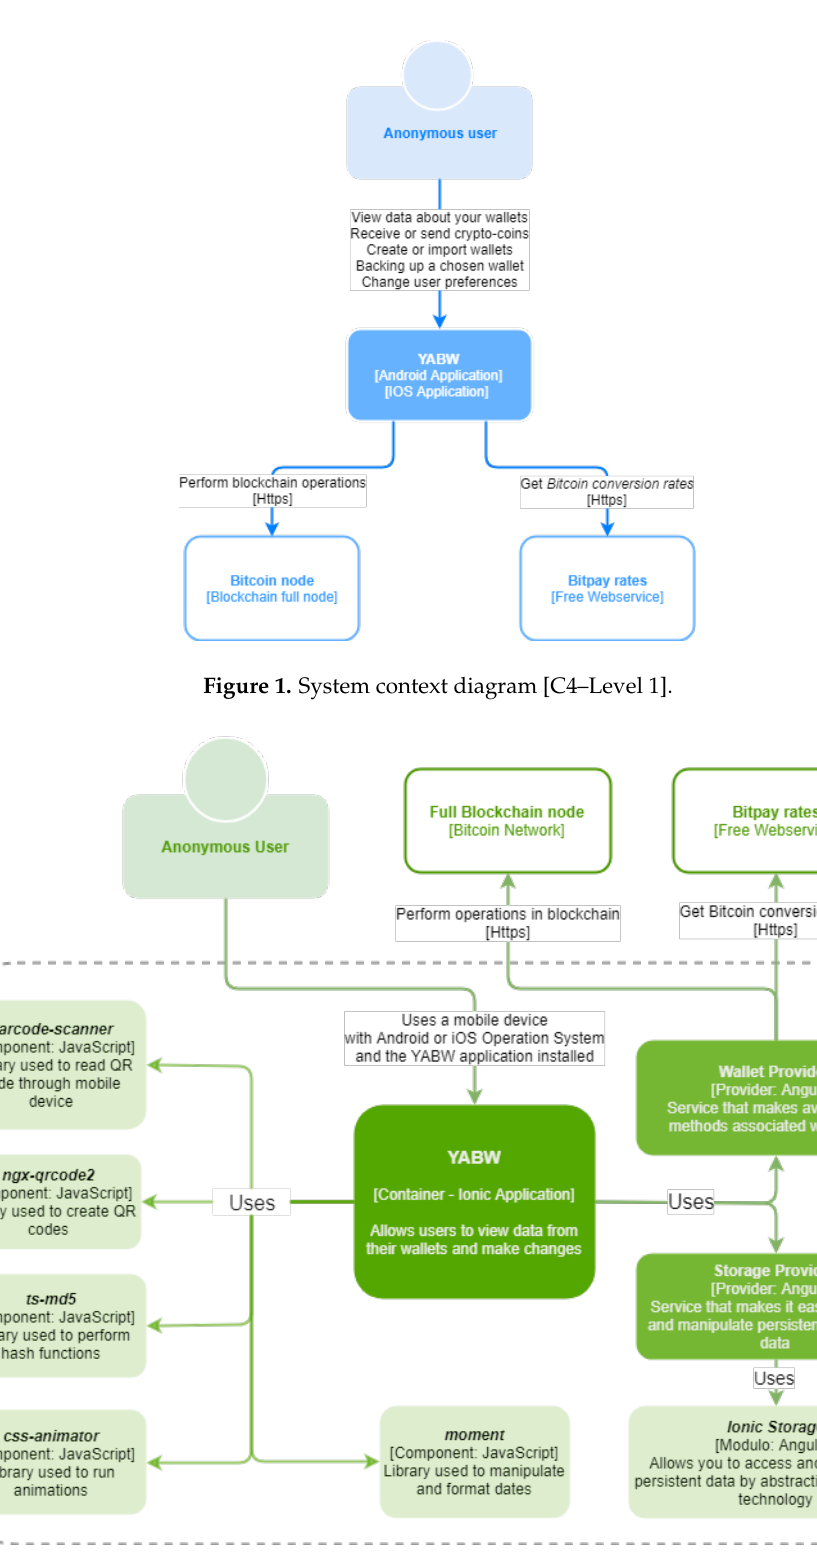
Figure 2. Containers diagram [C4–Level 2].